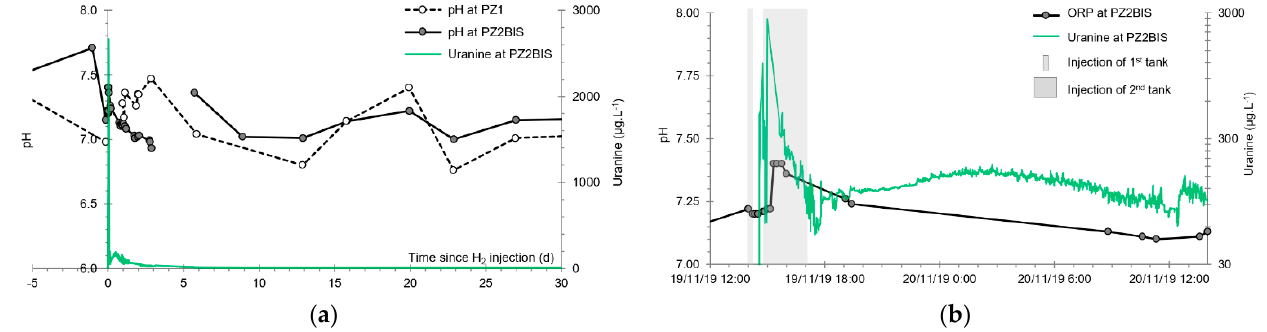
Figure 21. Comparative evolution of the pH and the tracer concentration at PZ2BIS (5 m downstream): ( a ) over a period of one month; and ( b ) during the first 24 h.